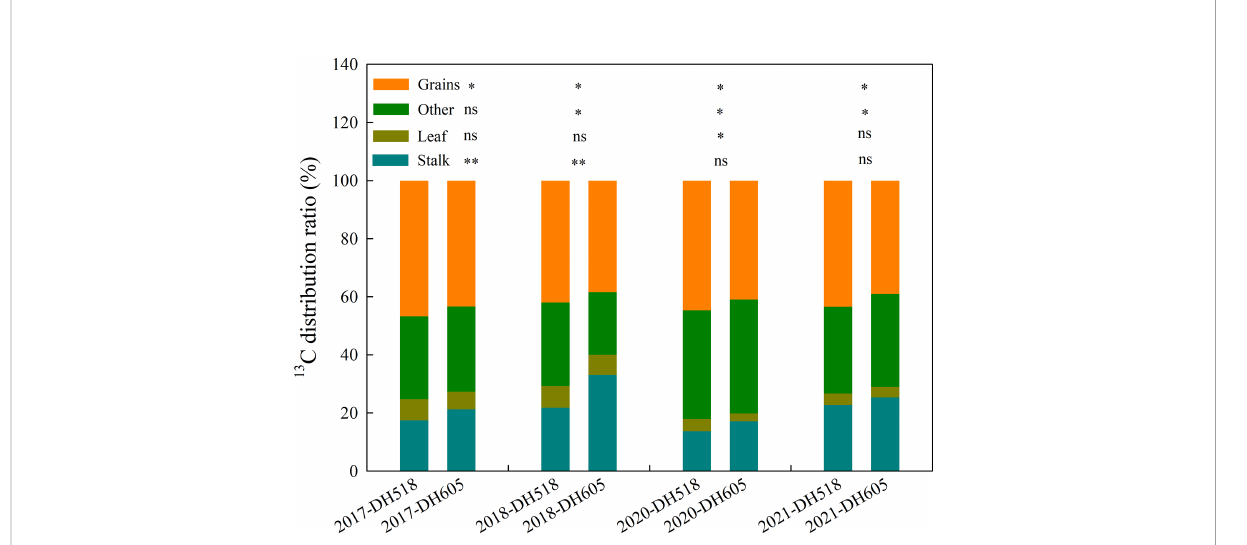
FIGURE 3 13 C distribution to organs of summer maize hybrids with different growth duration (2017-2018; 2020-2021). 2017, 2018, 2019, 2020 and 2021 were different years; DH518, Denghai518; DH605, Denghai605. Grain, leaf and stalk were 13 C distribution ratio to each organ; other were 13 C distribution ratio of bract and cob. ** and * indicated signi fi cantly different at the 0.01 and 0.05 probability levels, respectively; ns means there is no signi fi cantly different at the 0.05 probability levels, respectively.